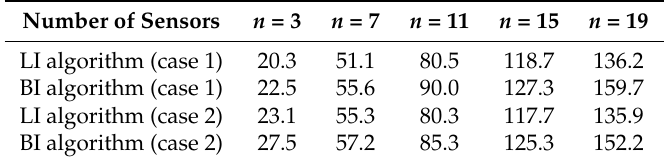
Table 1. Average total cruising length of three-dimensional (3D) Dubins curves (unit). LI denotes linear-interpolation-based 3D Dubins path planning; BI denotes Bezier interpolation based 3D Dubins path